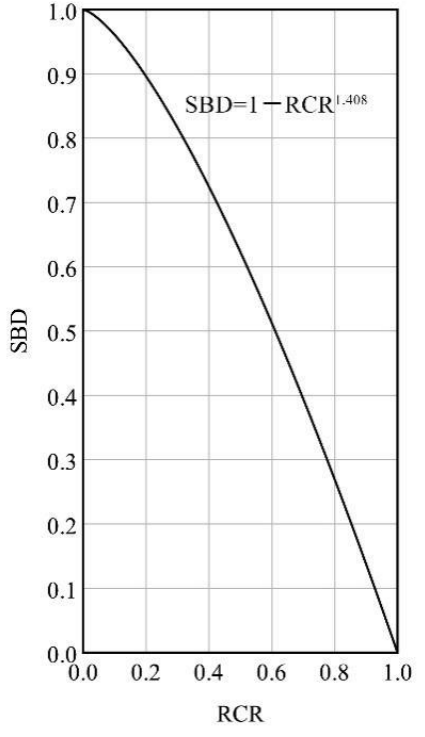
Figure 3. Fitting curves of three CPMs. ( a ) Power function; ( b ) quadratic parabolic function; ( c ) log-